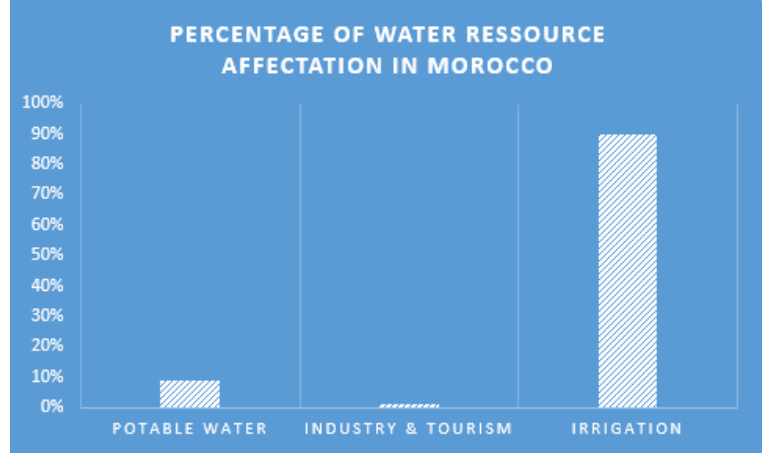
Figure 2. Water resource affectation in Morocco.